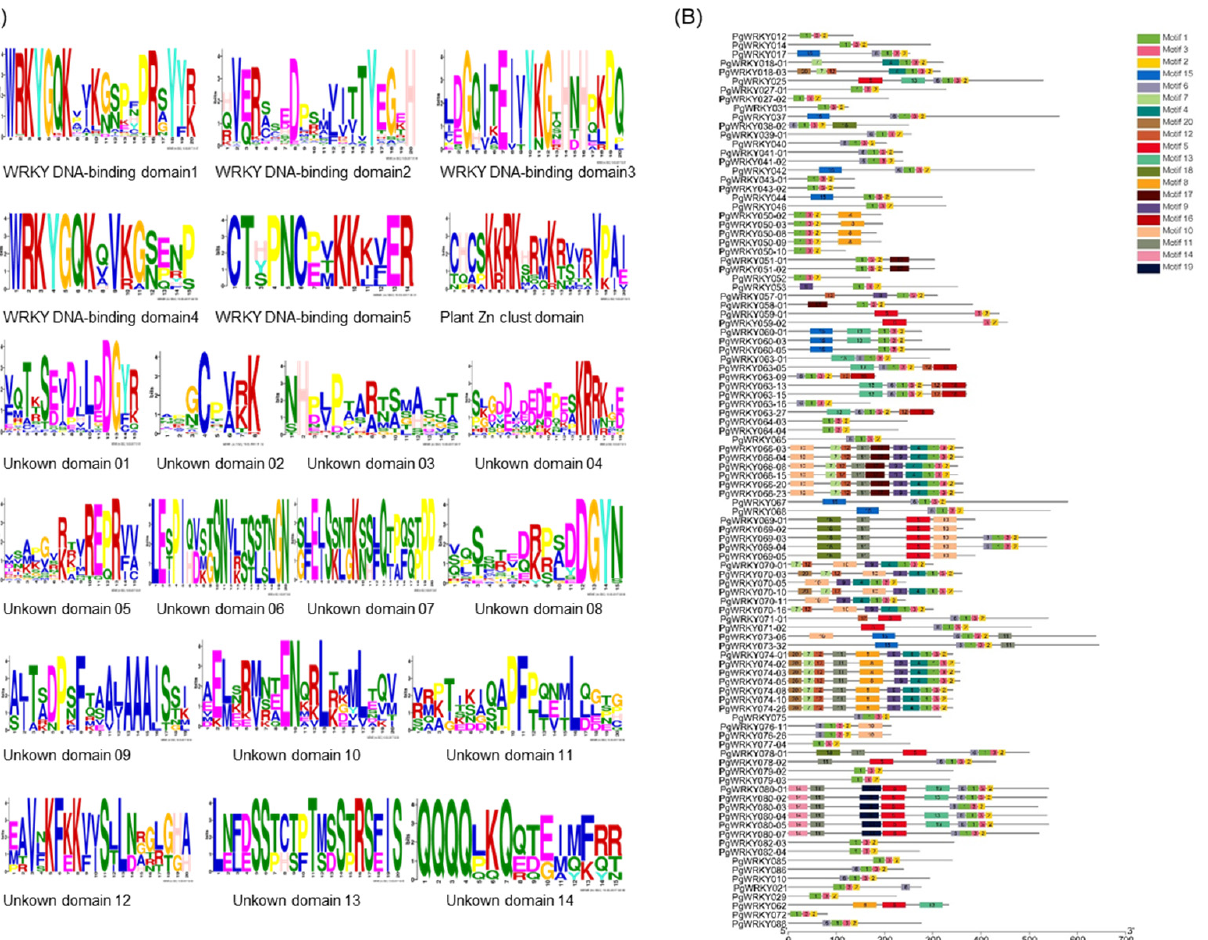
Figure 2. Distribution of 20 predicted conserved motifs in PgWRKY proteins. ( A ) 20 motifs revealed in PgWRKY proteins. ( B ) Conserved 20 motifs of PgWRKY proteins. The conserved motifs of the PgWRKY proteins are indicated by colored boxes. Motifs of PgWRKY proteins were identified by MEME and TBtools program.